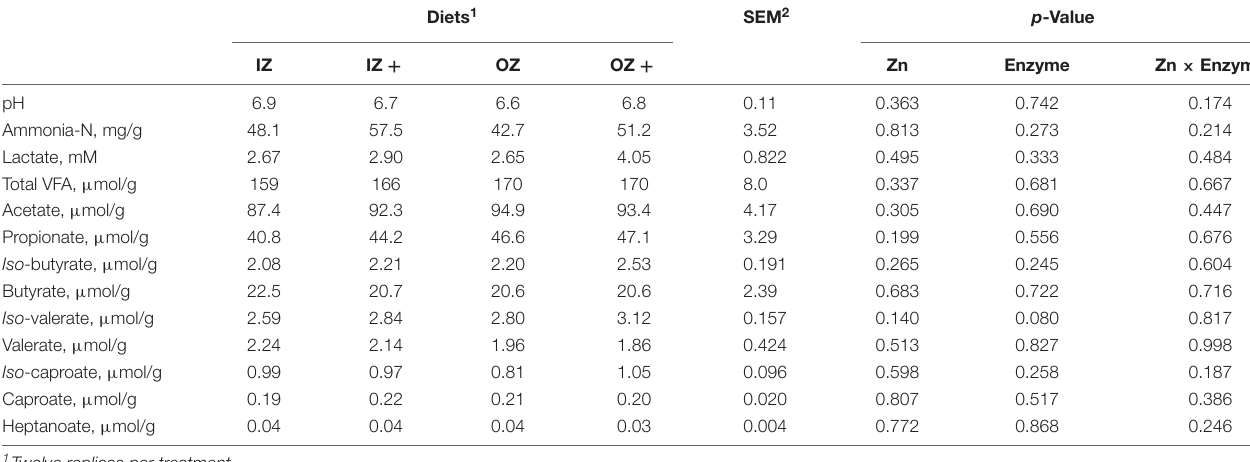
TABLE 4 | pH, ammonia-N, lactate, and volatile fatty acids (VFA) content and profile of feces collected from dogs fed diets supplemented with inorganic (IZ and IZ + ) and organic (OZ and OZ + ) Zn sources without (IZ and OZ) and with (IZ + and OZ + ) the addition of a multi-enzymatic complex from the solid-state fermentation of Aspergillus niger. Diets 1 SEM 2